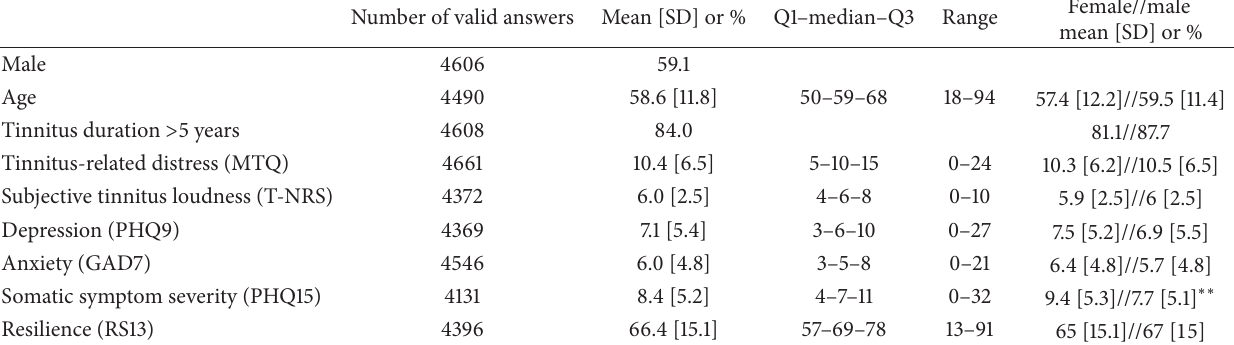
Table 1: Descriptive statistics.